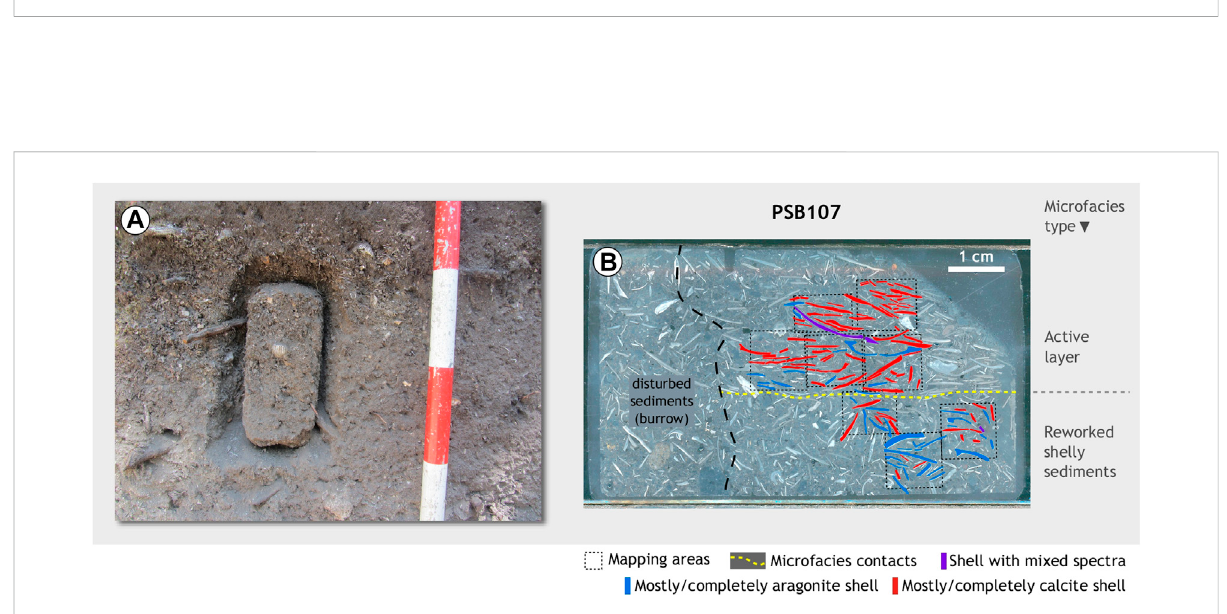
FIGURE 8 SampleCAM210: (A) Fieldphotographofthesampleinpro fi le,prior toblockextraction. (B) Thinsectionscanofthesamplesshowingindividual shells ’ overall mineralogy obtained through